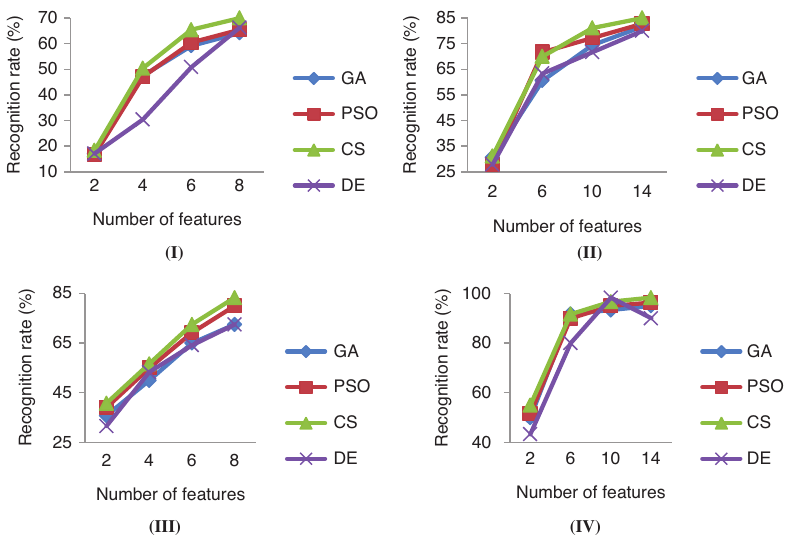
Figure 6: Effect of Noise on the Recognition Rate of Different Algorithms for ORL Case 2: (I) 40 Classes, (II) 30 Classes, (III) 20 Classes, and (IV) 10 Classes.